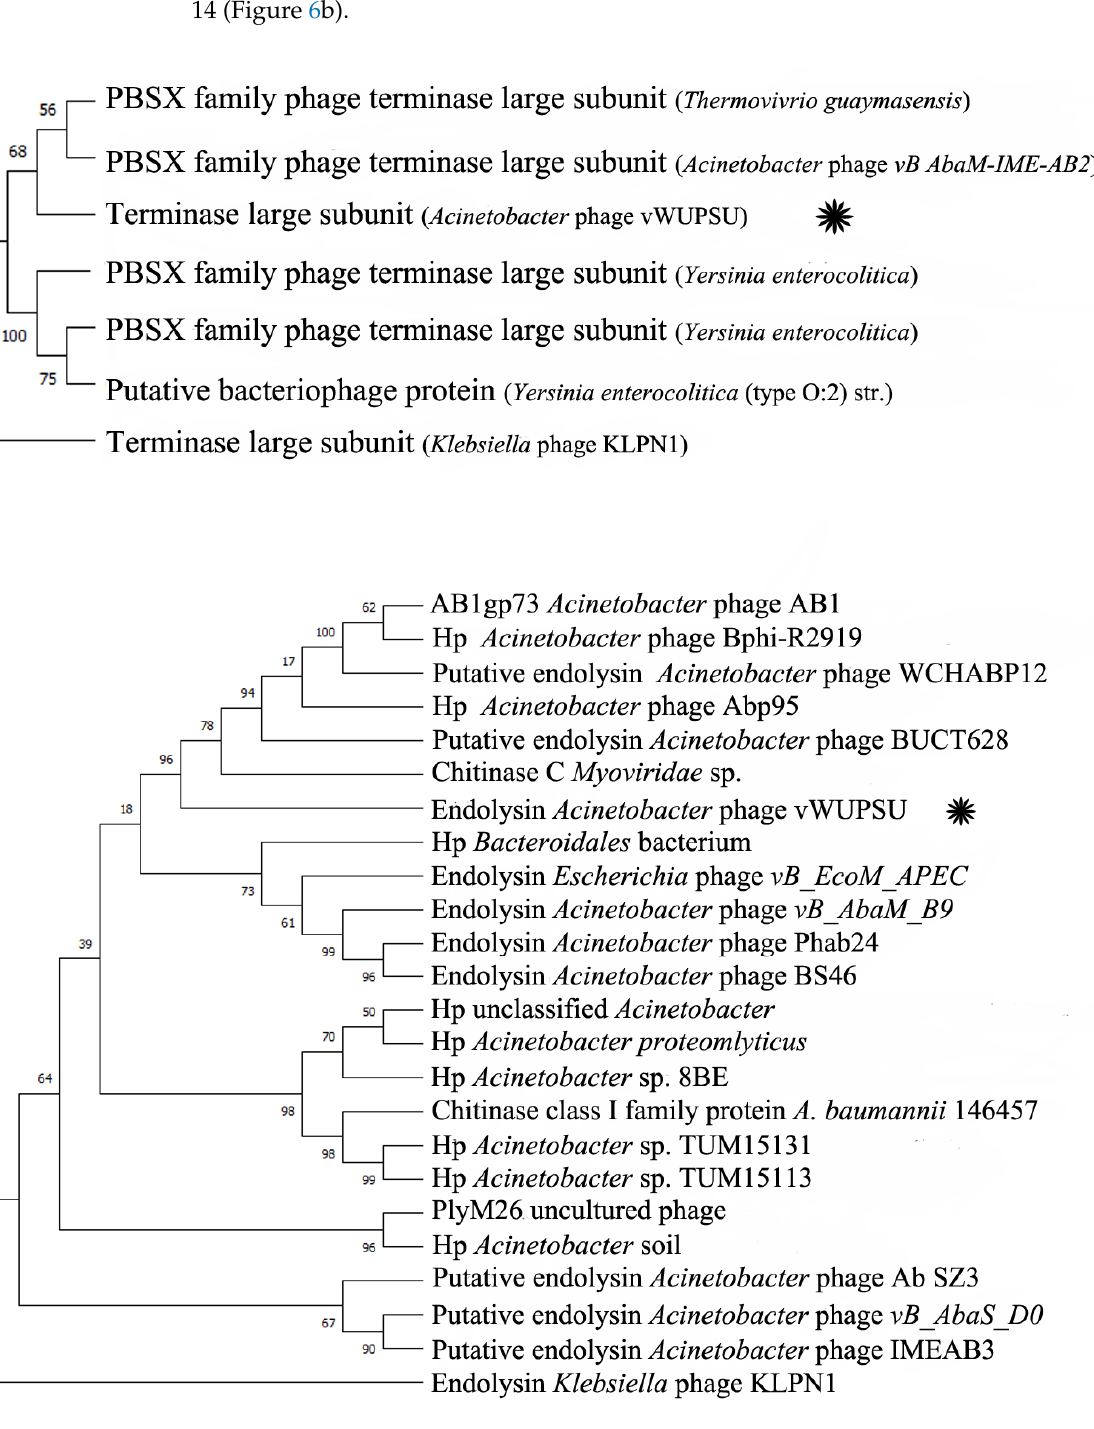
Figure 3. Phylogenetic tree of phage terminase large subunit and endolysin. The maximum likeli- hood phylogenetic trees of ( a ) phage terminase large subunit and ( b ) endolysin based on the align- ment of amino acid sequences were constructed by maximum-likelihood phylogenetic tree based on the JTT matrix-based model using 1000 bootstrap replicates [33]. The query sequence is marked with an asterisk. Hp is a hypothetical protein. asterisk. Hp is a hypothetical